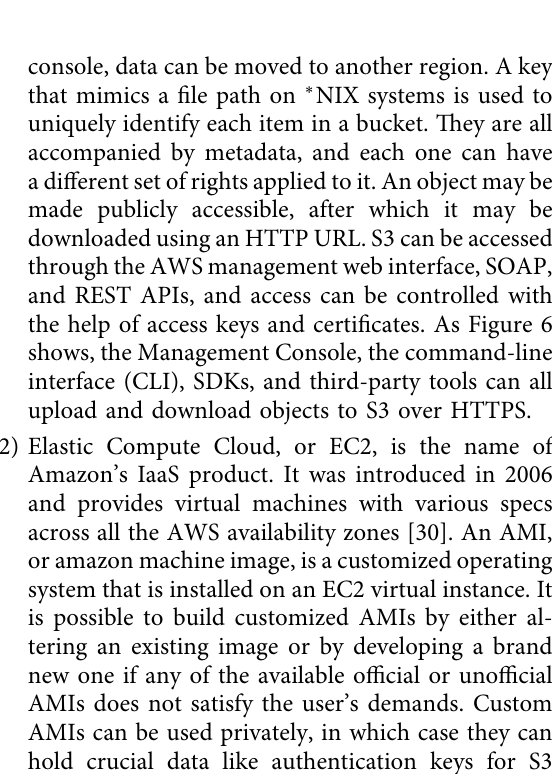
Figure 5: IaaS, PaaS, and SaaS.